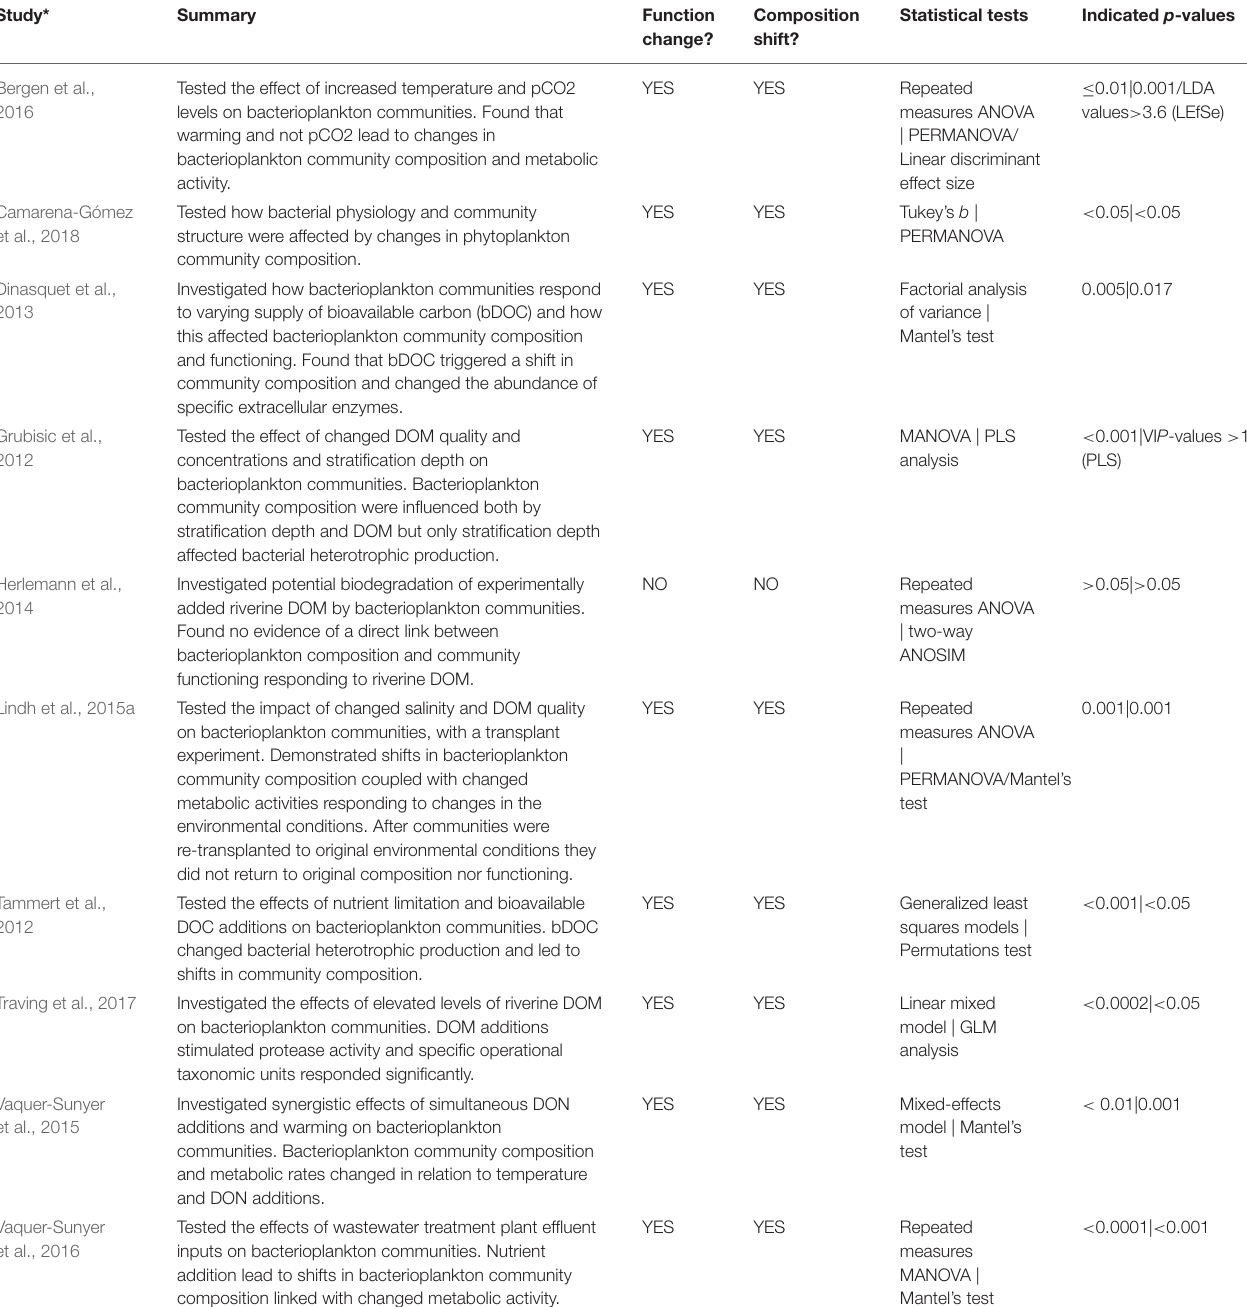
TABLE 2 | Summary of Baltic Sea bacterioplankton studies in which experimental data with empirical testing of the effect of natural or anthropogenically induced disturbances on total bacterioplankton community composition and functioning have been determined concomitantly ( n = 10). Study* Summary Function